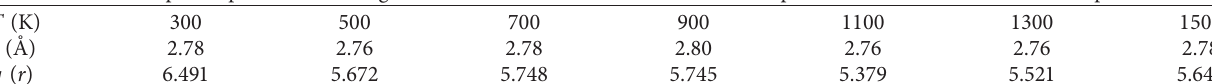
Table 5: First peak’s position and height of radial distribution function for amorphous aluminium at different temperatures.